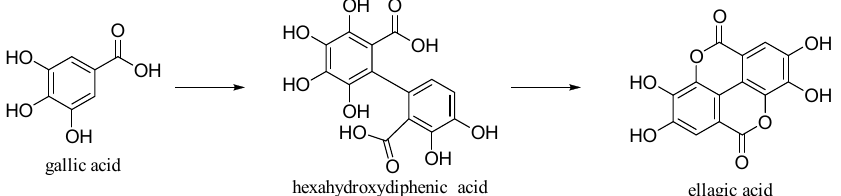
Figure 14. Gallic and ellagic acids .